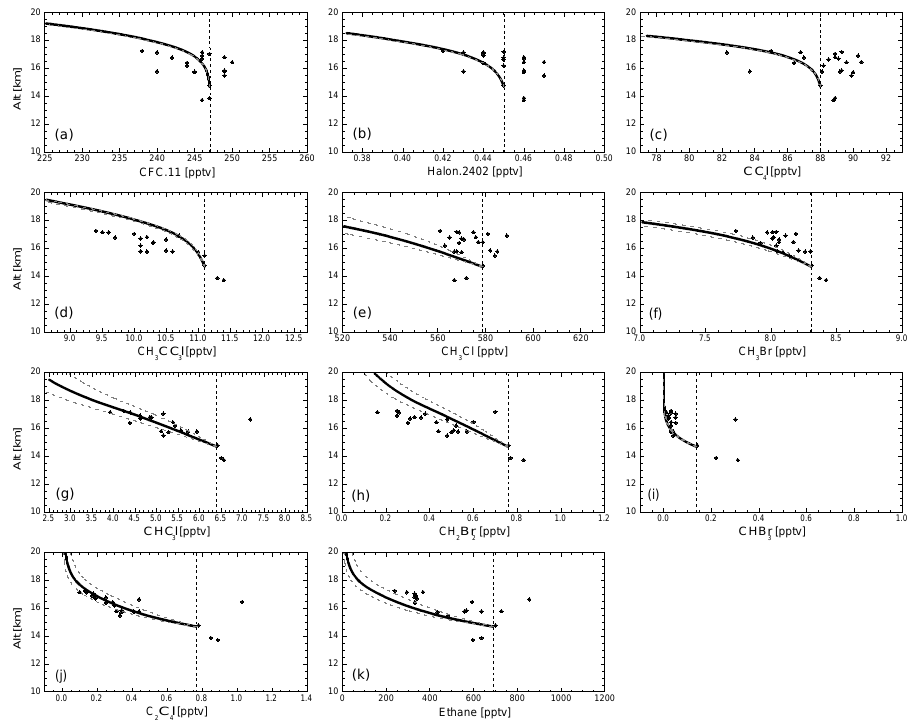
Fig. 9. Vertical distributions of (a) CFC-11, (b) Halon-2402, (c) CCl 4 , (d) CH 3 CCl 3 , (e) CH 3 Cl, (f) CH 3 Br, (g) CHCl 3 , (h) CH 2 Br 2 , (i) CHBr 3 , (j) C 2 Cl 4 and (k) ethane. Plotted are individual data points (solid circles) measured by WAS on 6 August and the 1-D model results (solid lines) with a set of input parameters determined from the analysis on the 5 August